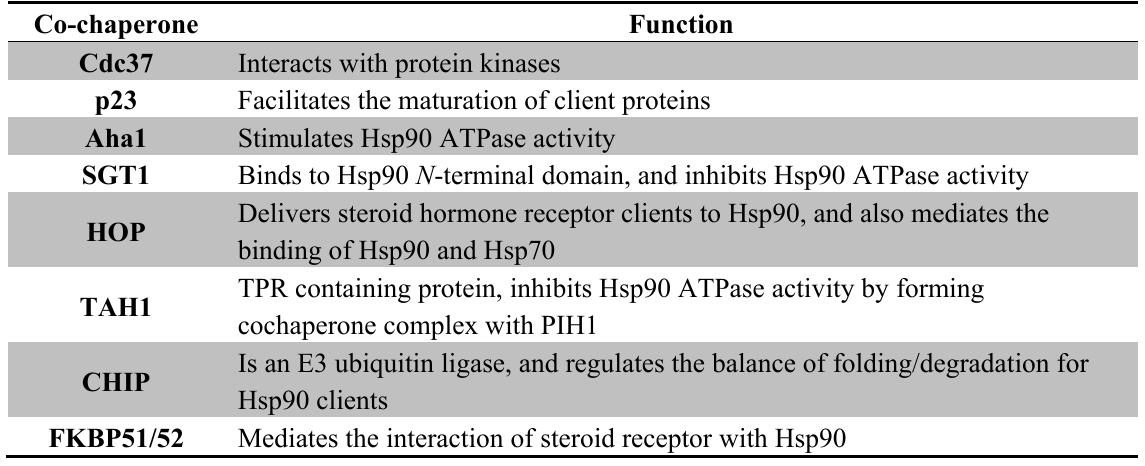
Table 1. Co-chaperones of